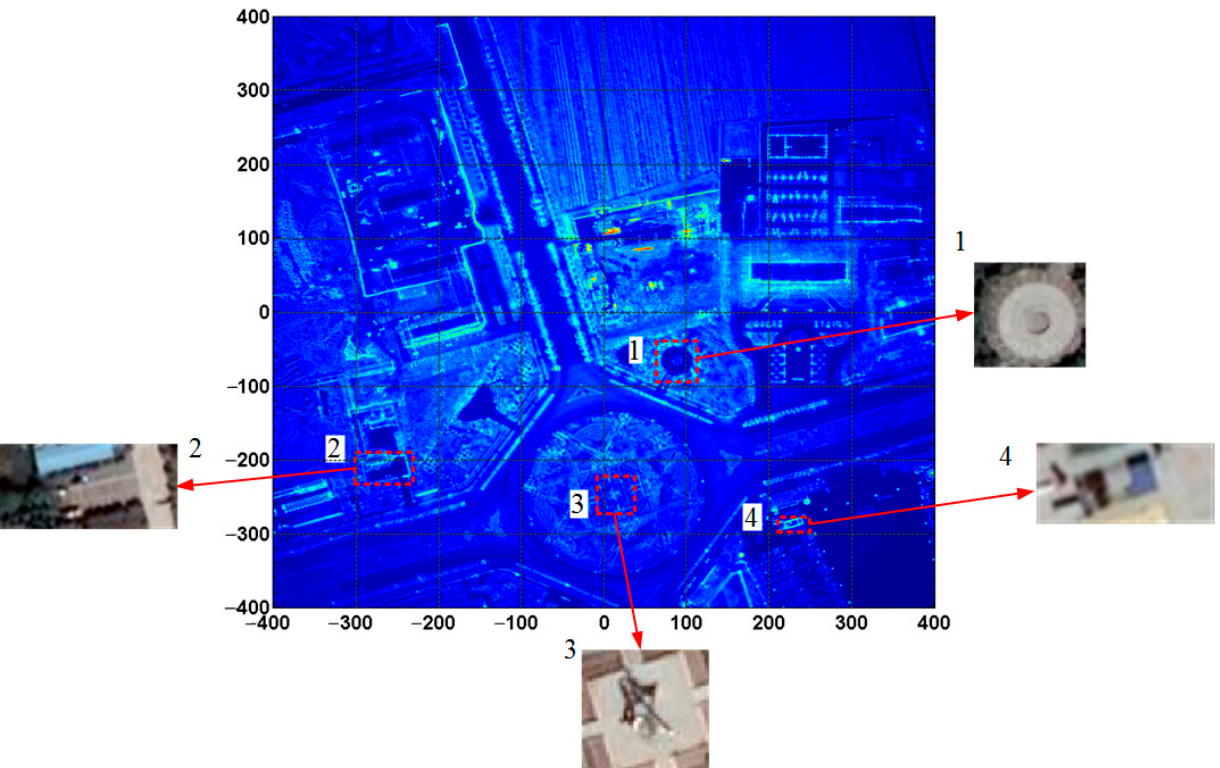
Figure 27. The image fusion result of all frames.